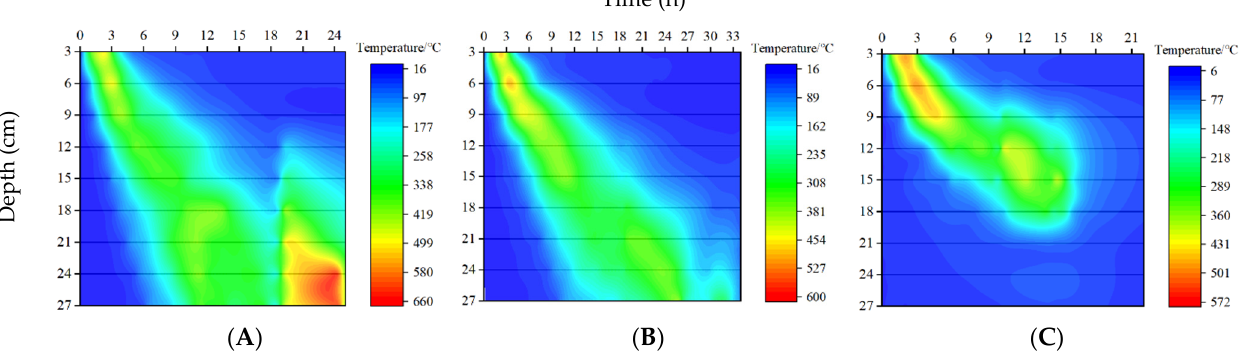
Figure 4. Smoldering characteristics of humus with different moisture content (samples ( A – C ): Smoldering temperatures of lower humus depths with moisture content of 20%, 30%, and 40%).